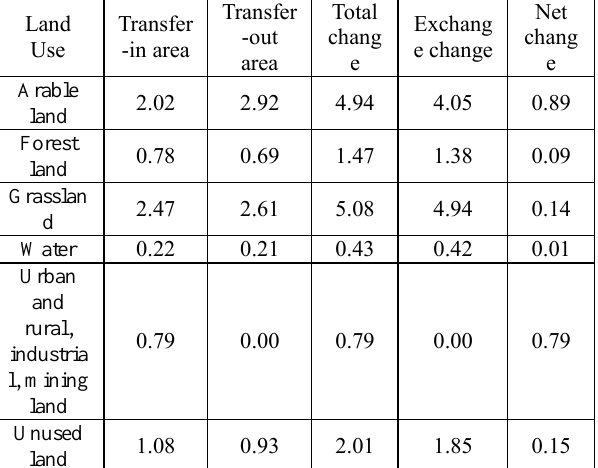
Table 3. Land use change from 1978 to 2018 (Unit: 10,000 km 2 ) Land